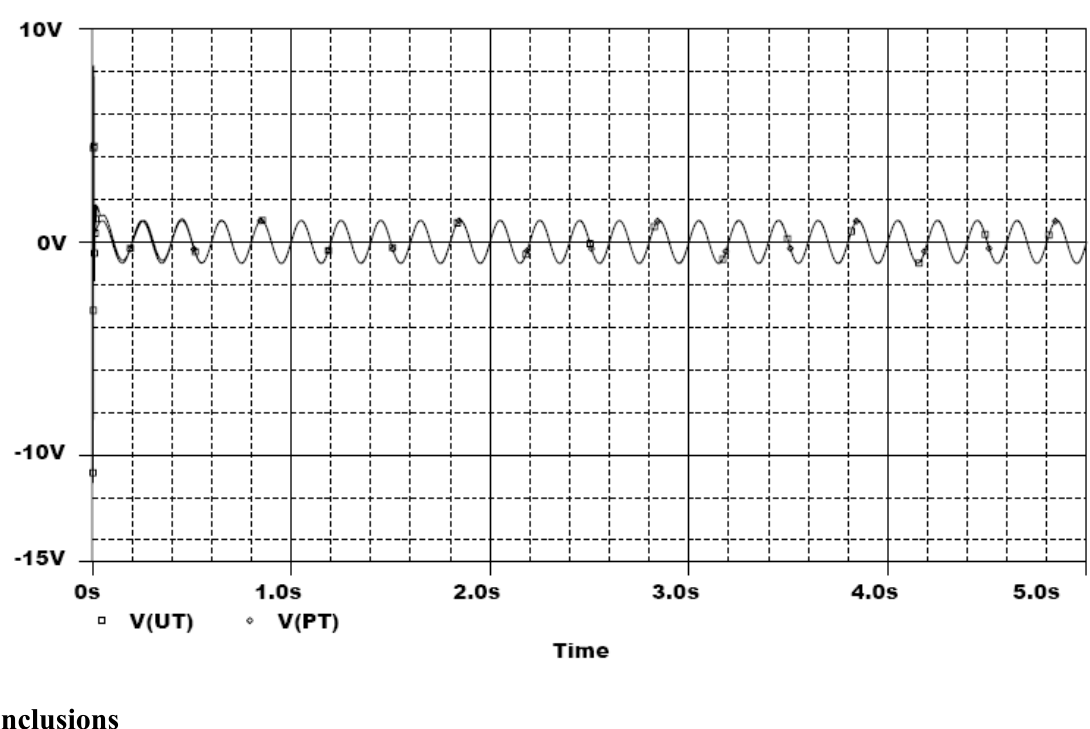
( t ) and input message p eq